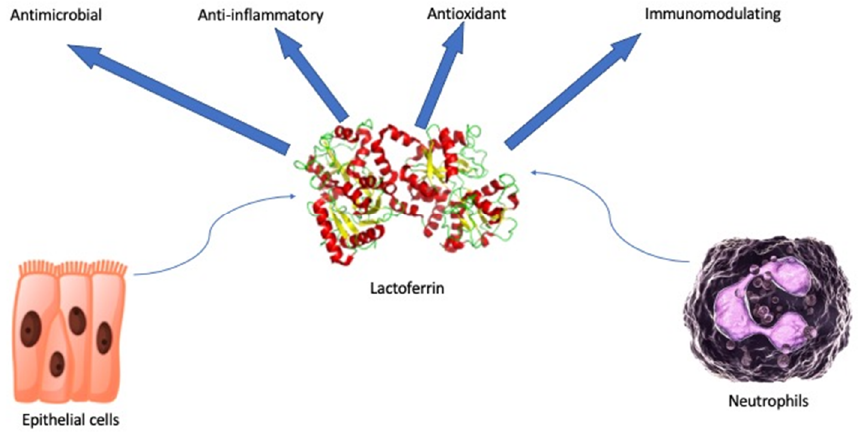
Figure 1. Schematic representation of pleiotropic and beneficial effects of secreted lactoferrin .